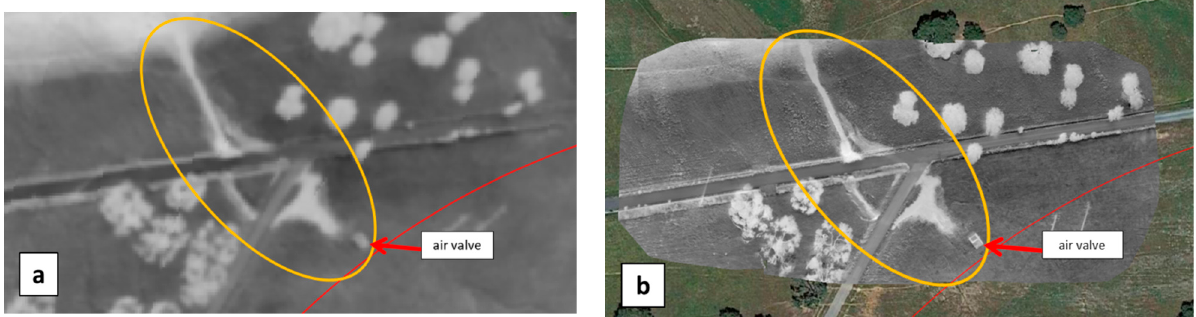
Figure 20. ( a ) Close ‐ up of the WI image in Figure 19 over the northeast “water anomaly”. ( b ) WI image obtained in the same area as the UAV on 11 September. (FOV: 83 m × 67 m). Water is flowing in northwest direction from the concrete block containing an air valve and splits in two arms (light grey marks in the yellow ellipse). The two arms run under the road and join downstream before reaching a field with central pivot irrigation in the north.